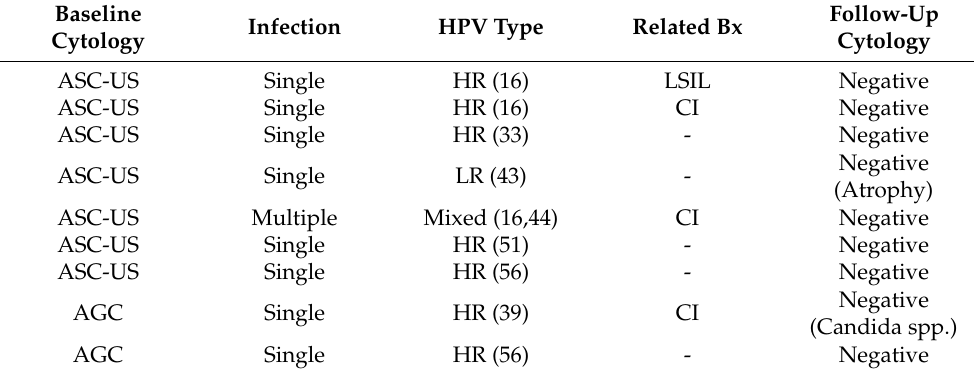
Table 4. Clinical characteristics of abnormal baseline cytology.